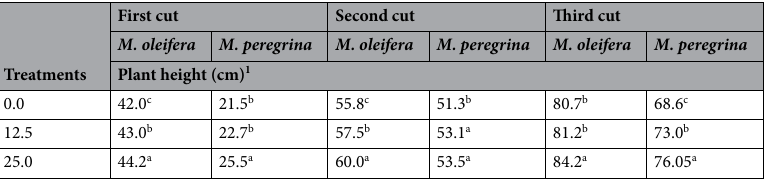
Table 4. The effect of selenium fertilization (mg Se/L) on plant height of M. oleifera and M. peregrina at different cutting periods. 1 Means within each column with the same superscripts were not significantly different using Duncan Multiple Range Test at the 0.05 level of significance.